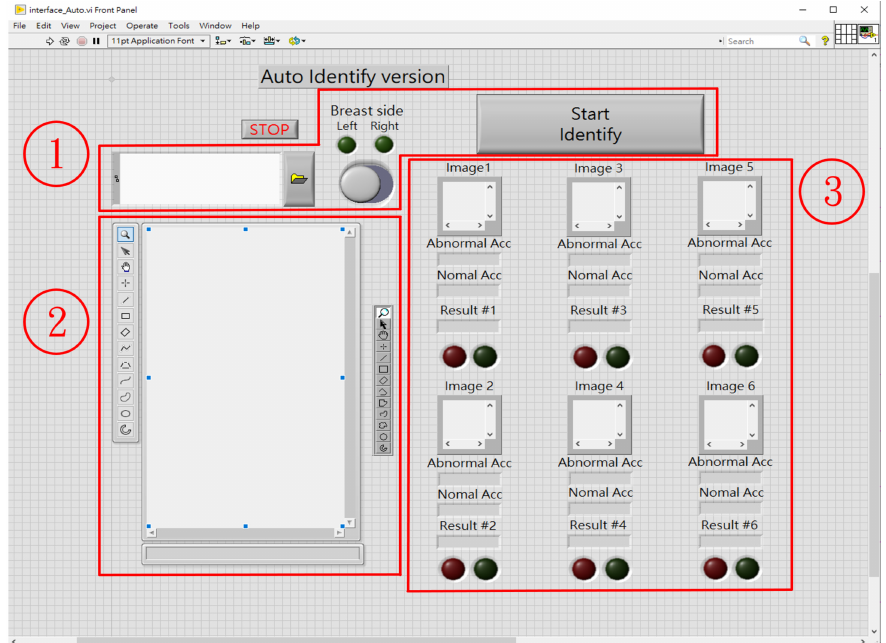
Figure 4. The human machine interface for automatic breast tumor screening: Zone 1 (cid:13) : Sets the source path of images, Zone 2 (cid:13) : Loads and displays the images, Zone 3 (cid:13) : Extract ROI images and perform automatic tumor